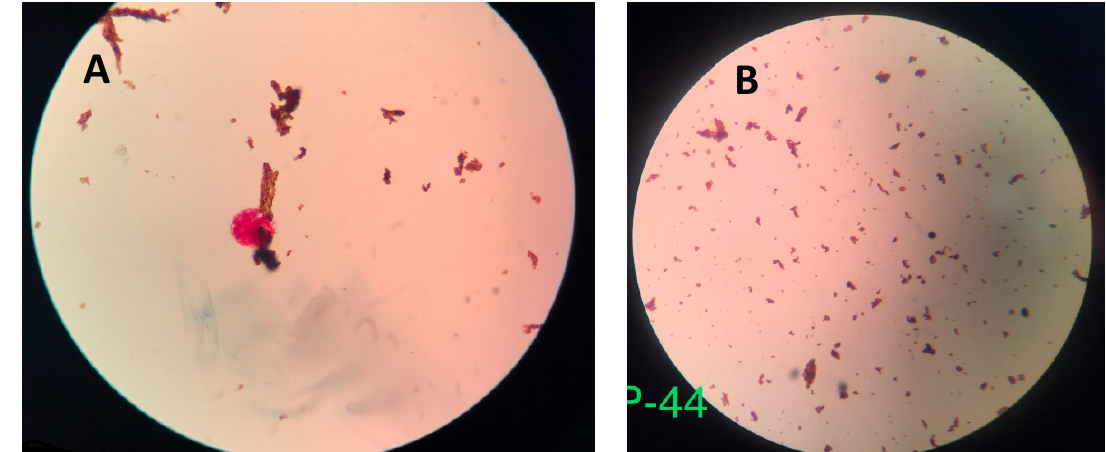
Figure 4. Left: Percent detection by NCBA and SSM with respect to the Xpert MTB/RIF system. SSM detection increases linearly with acid-fast bacillus (AFB) concentration in the sputum sample. Right: TB positive samples are normally distributed around the medium level.